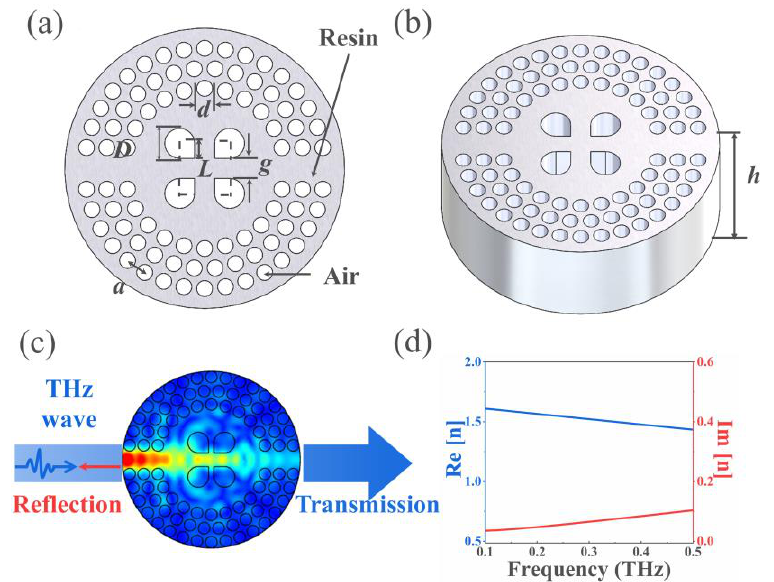
Figure 1. ( a ) The 2D structure of the THz PC waveguide. ( b ) The 3D structure of the THz PC waveguide. ( c ) The process of reflection and transmission characteristics of the THz PC waveguide. ( d ) The real and imaginary parts of the refractive index (RI) of the photosensitive resin.